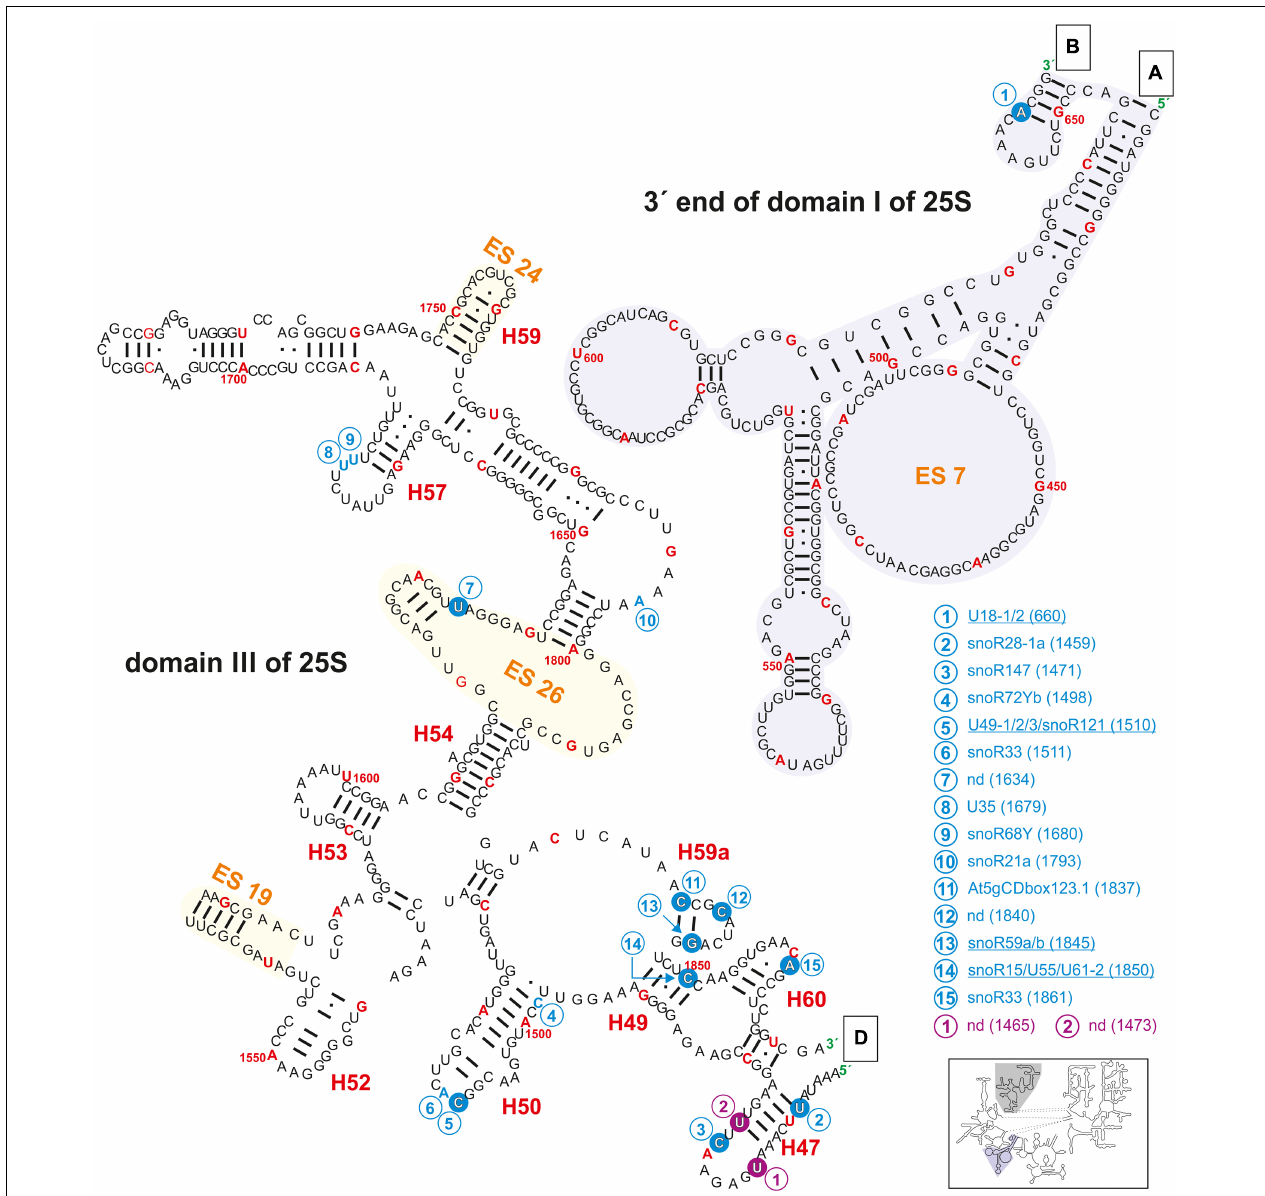
FIGURE 4 | Secondary structure diagram of the 3 (cid:48) end of domain I (gray background) as well as of domain III of 25S rRNA of A. thaliana . The image is shown according to the legend for Figure 3 . Framed large letters indicate the position of the connections in subsequent images (for A see Figure 3 ; for B see Figure 6 ; for D see Figure 5 ). The number in brackets correspond to the modified nucleotide position. A small illustration of the whole 60S rRNA secondary structure highlighting the according region is